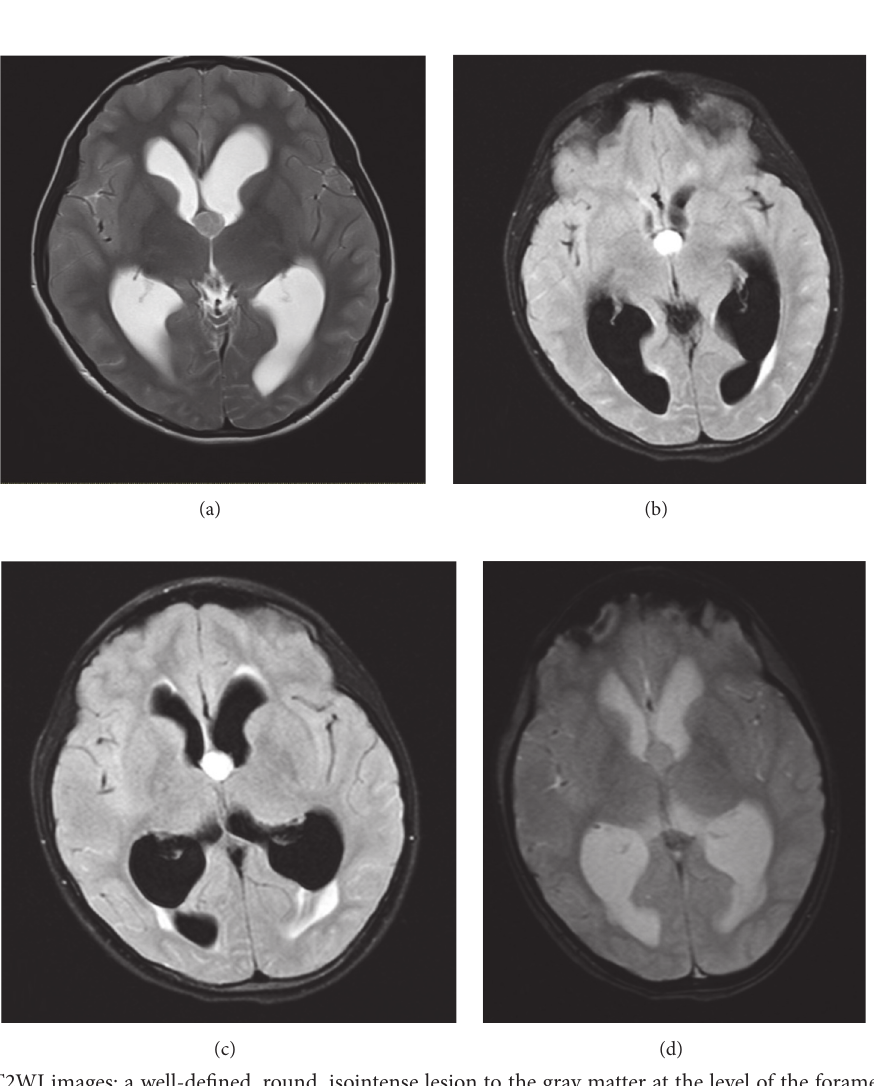
Figure 2: (a) Axial T2WI images: a well-defined, round, isointense lesion to the gray matter at the level of the foramen of Monro causing moderate acute hydrocephalus. (b, c) FlAIR and T1WI: the lesion is hyperintense relative to brain parenchyma. (d) T 2 ∗ GRE images: no drop of signal to indicate intralesional